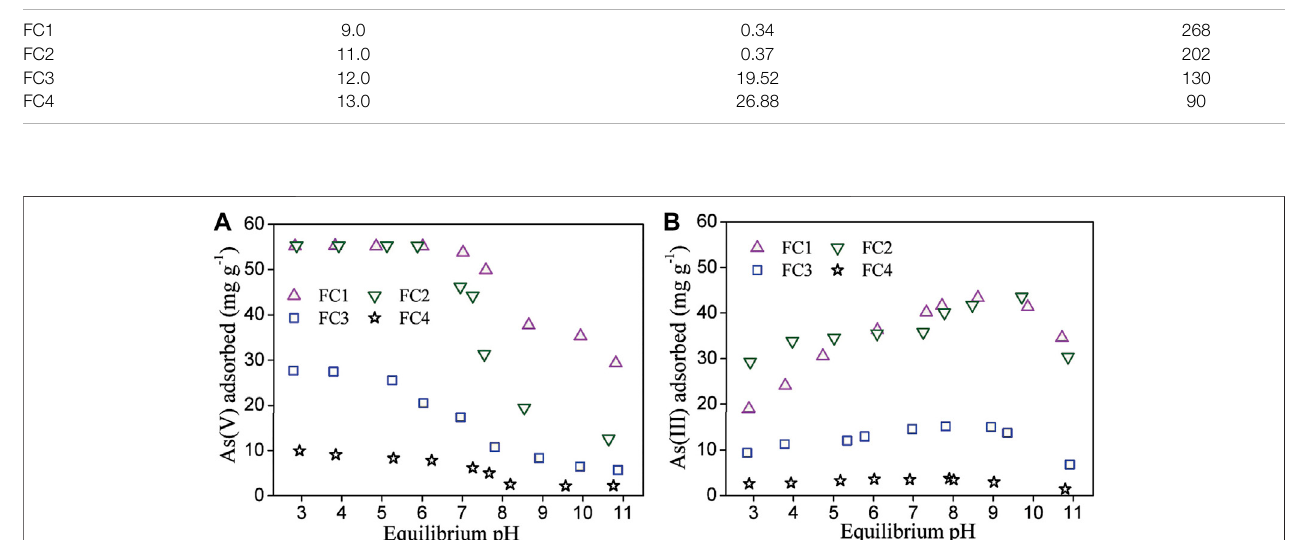
TABLE 1 | Saturation magnetization and BET speci fi c surface area of the as-prepared Fe-Cu binary oxide samples. Samples